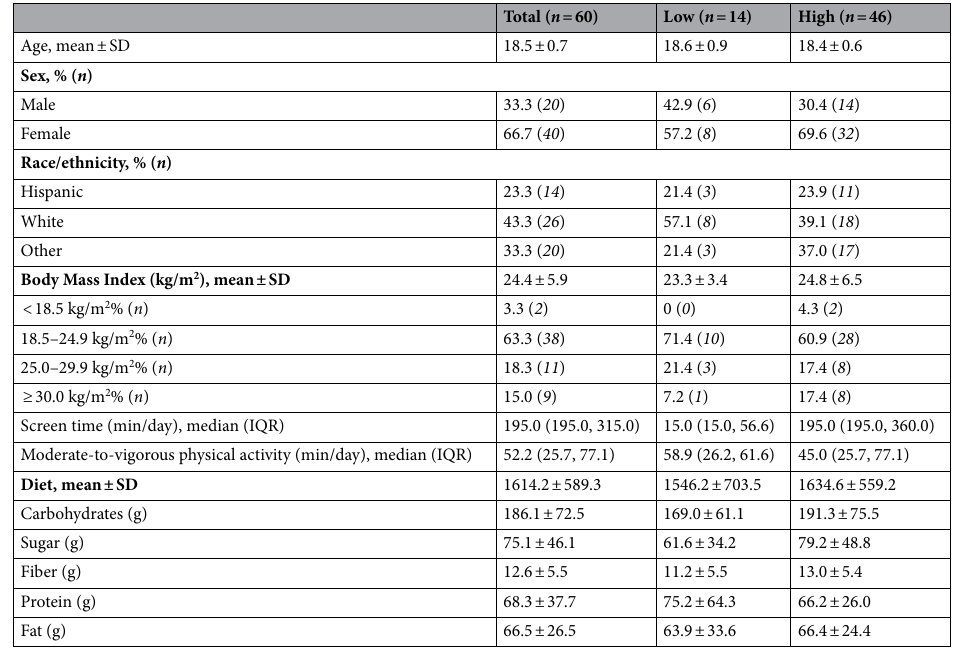
Table 1. Participant characteristics by screen time classification. IQR interquartile range, SD standard